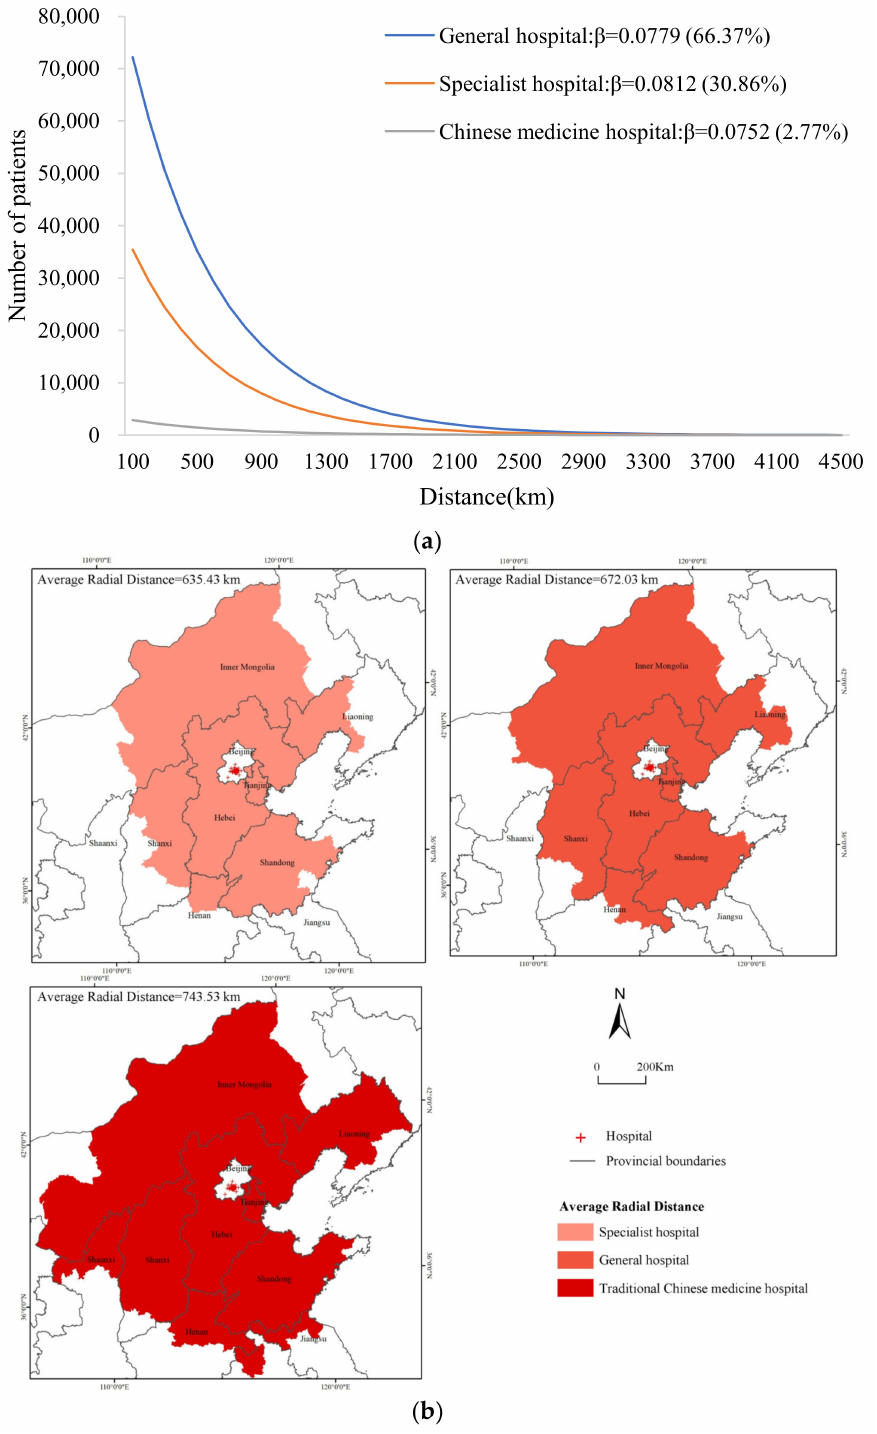
Figure 4. Hospital service utilization of different types. ( a ) Fitting graph of the number of cross- regional patients according to distance in hospitals of different types. ( b ) The AR of hospitals of different